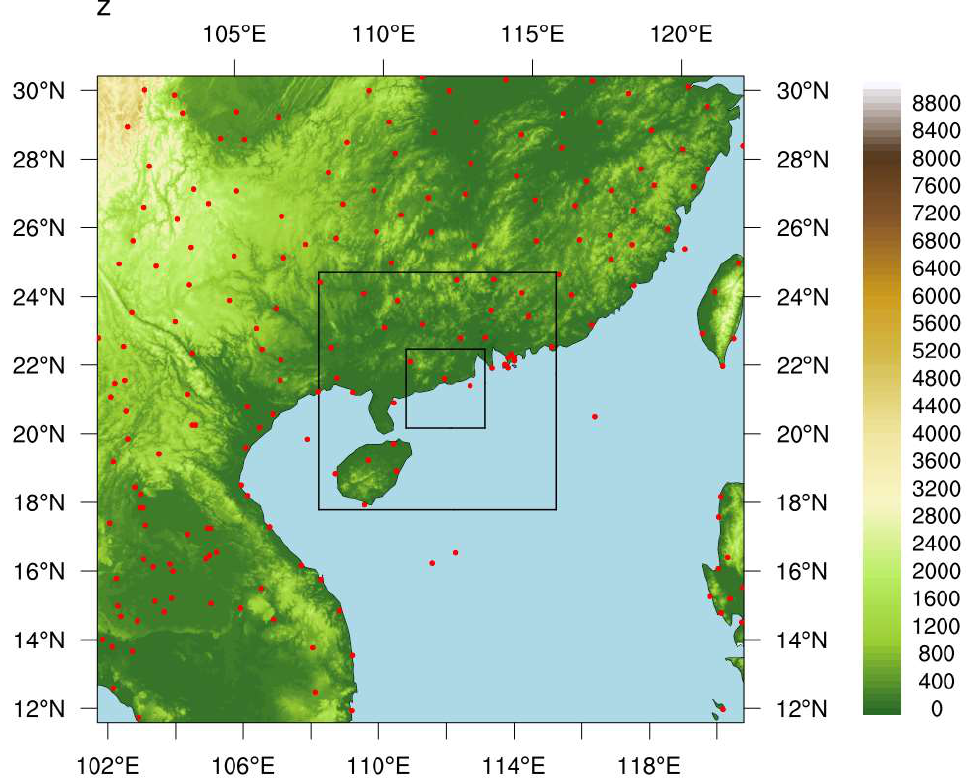
Figure 3. Locations of synoptic observation stations (red dots).